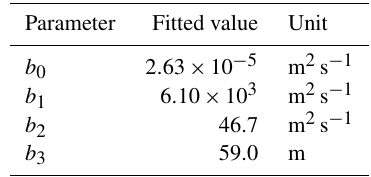
Table 1. Fitted parameters of the statistical